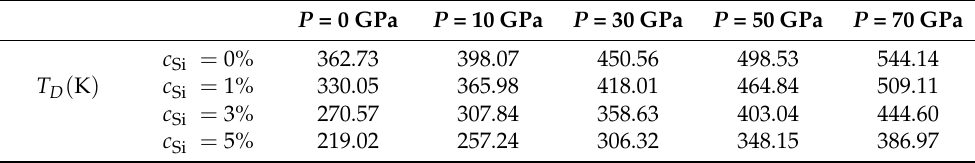
Table 7. Si concentration and pressure dependence of Debye temperature T D for WSi at T = 300 K.